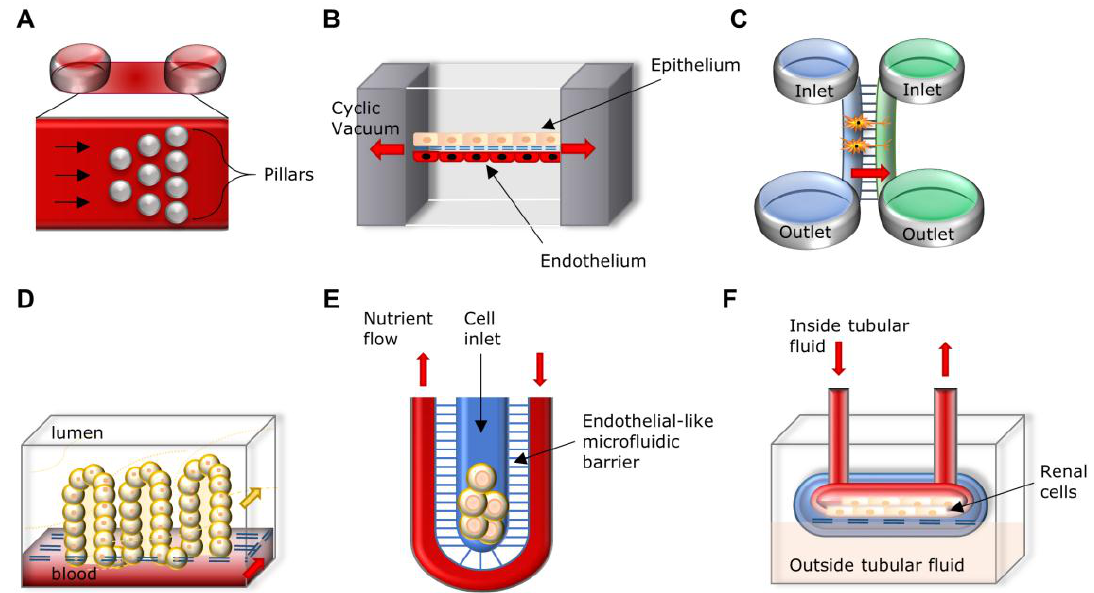
Figure Figure 1. Illustration of the diverse microfluidic devices used to study biological processes occurring in vascular, respiratory, nervous, digestive and excretory systems. A. Biochip with subdividing interconnecting microchannels (array of pillars) that decrease in size to mimic cell flow and adhesion in microvasculature to study of vaso-occlusive processes. B. Human